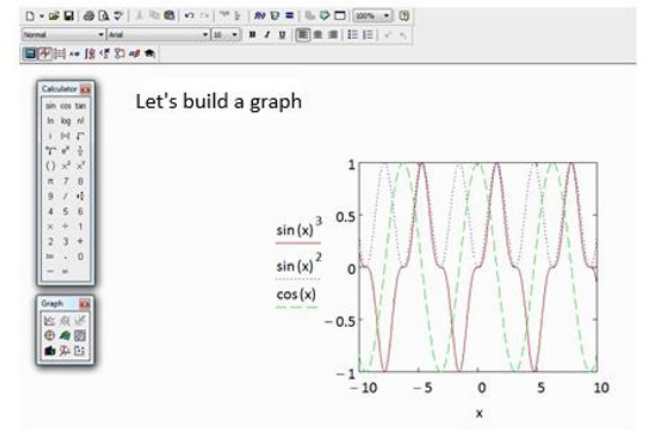
Fig. 2. Video frame of the topic “Plotting Function Graphs in